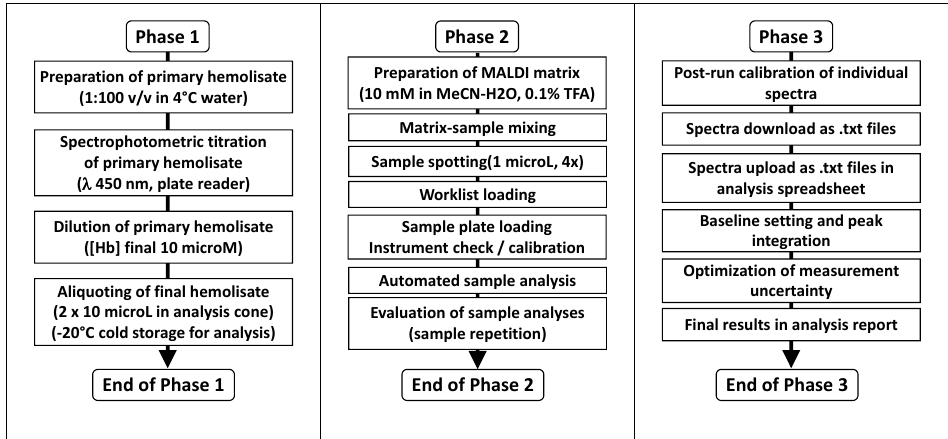
Figure 4. Three-phase analysis flowchart for the measurement of glutathionyl-hemoglobin in human red blood cells. The three phases are organized to allow manual sample preparation, analysis and processing in batches by a single Operator with data reporting over a weekly shift.